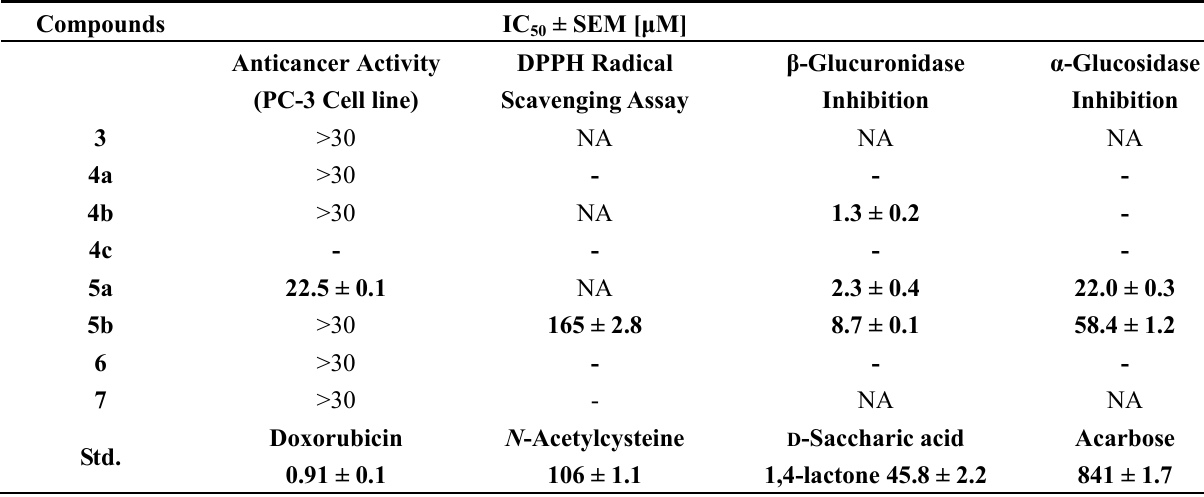
Table 1. Results of various biological assays on compounds 3 – 7